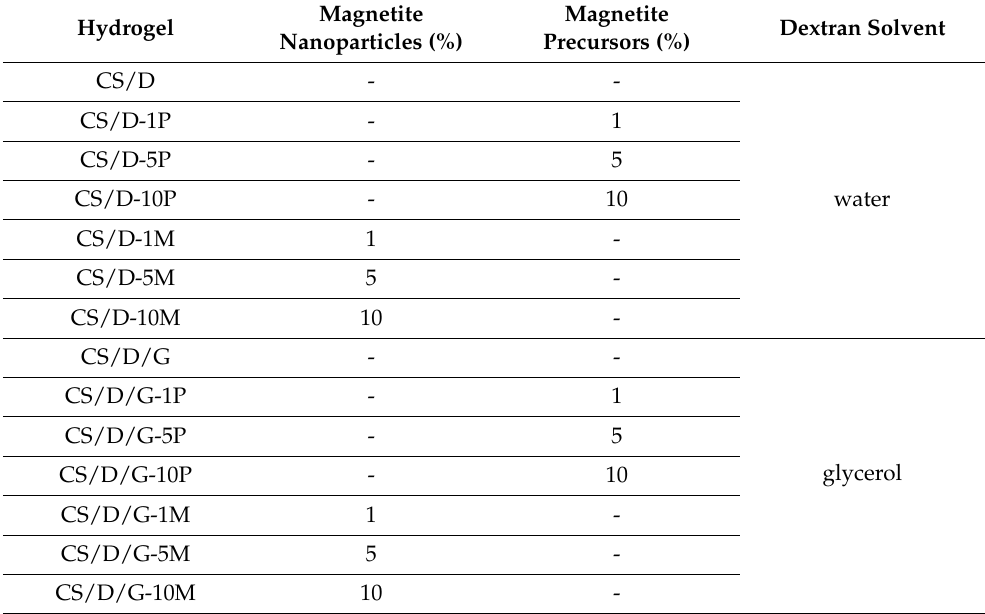
Table 1. Summary of the composite hydrogels obtained and their